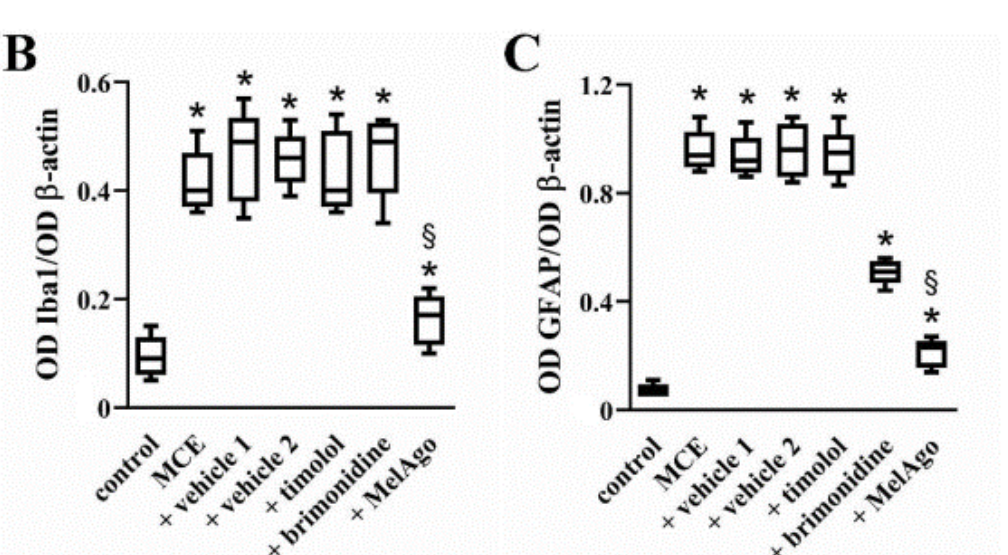
Figure 4. Glial activation. ( A ) Representative Western blots from retinal homogenates of control rats or rats that received MCE, either untreated or treated with vehicles, timolol, brimonidine, or melatonin / agomelatine. ( B , C ) Densitometric analysis of ionized calcium binding adaptor molecule 1 (Iba1; B ) and glial fibrillary acidic protein (GFAP; C ). MCE increased the levels of both Iba1 and GFAP. Iba1 and GFAP increase was una ff ected by vehicles or timolol. Brimonidine reduced GFAP increase, but not Iba1 increase. Melatonin / agomelatine reduced both Iba1 and GFAP increase. Data are shown as box and whiskers plots ( n = 6 samples, each containing two retinas, for each experimental group). * p < 0.05 versus control; § p < 0.05 versus the respective vehicle (one-way ANOVA followed by Tukey post-hoc test). MelAgo, melatonin /